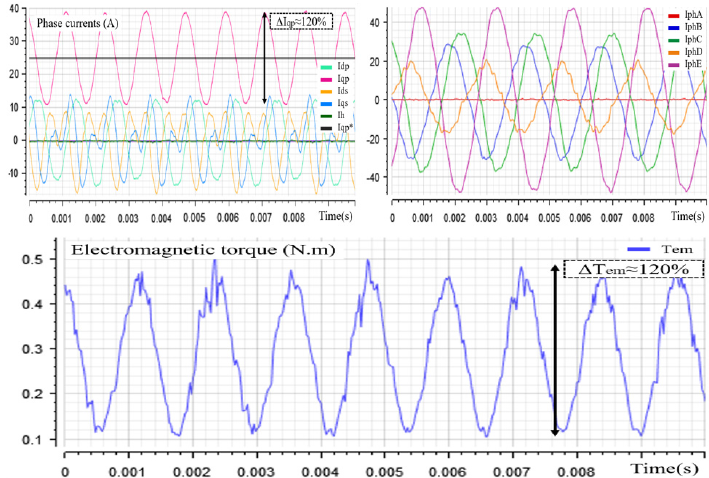
Figure 10. Stator currents and electromagnetic torque in Faulty condition.